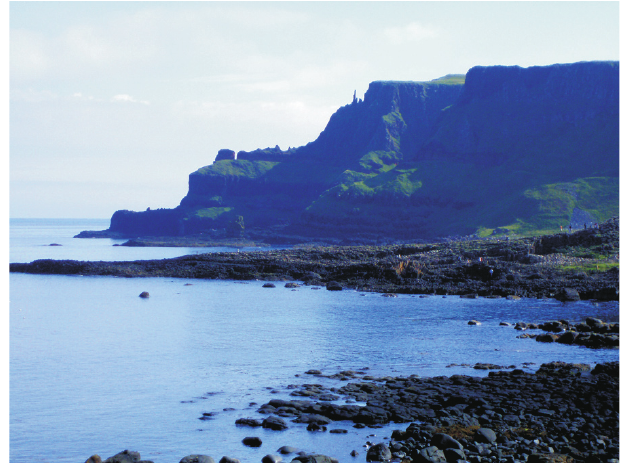
Figure 2. Giant’s Causeway (Ireland), part of the North Atlantic LIP. Note the stepped topography in the background, characteristic of flood basalt